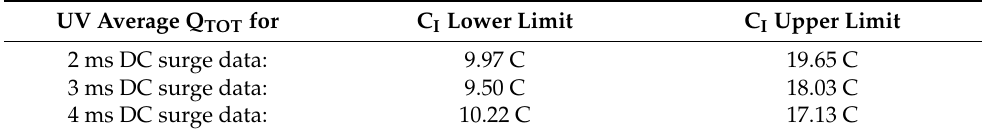
Table 5. Confidence interval limits of UV average Q TOT